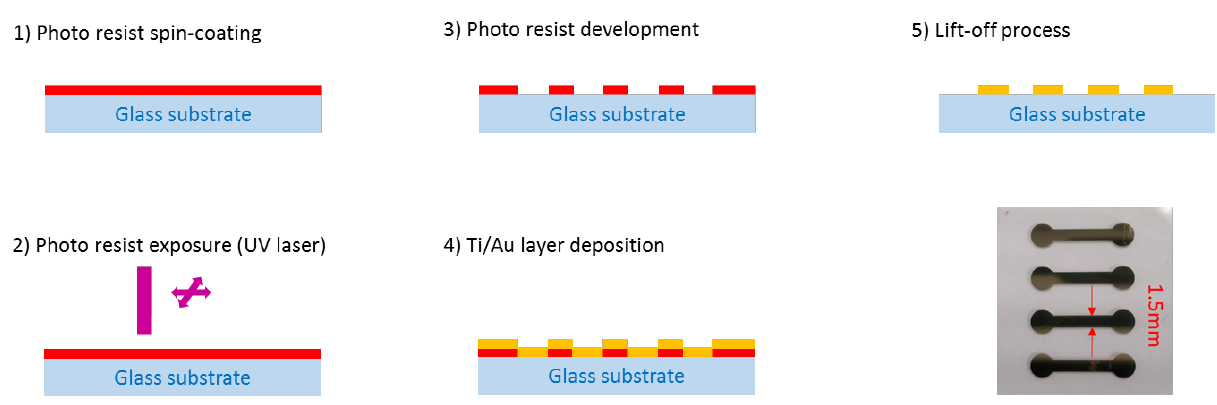
Figure 2. Process flow for the fabrication of the plasmonic sensor. View of the four-channel surface plasmon resonance (SPR) sensors (bottom right).